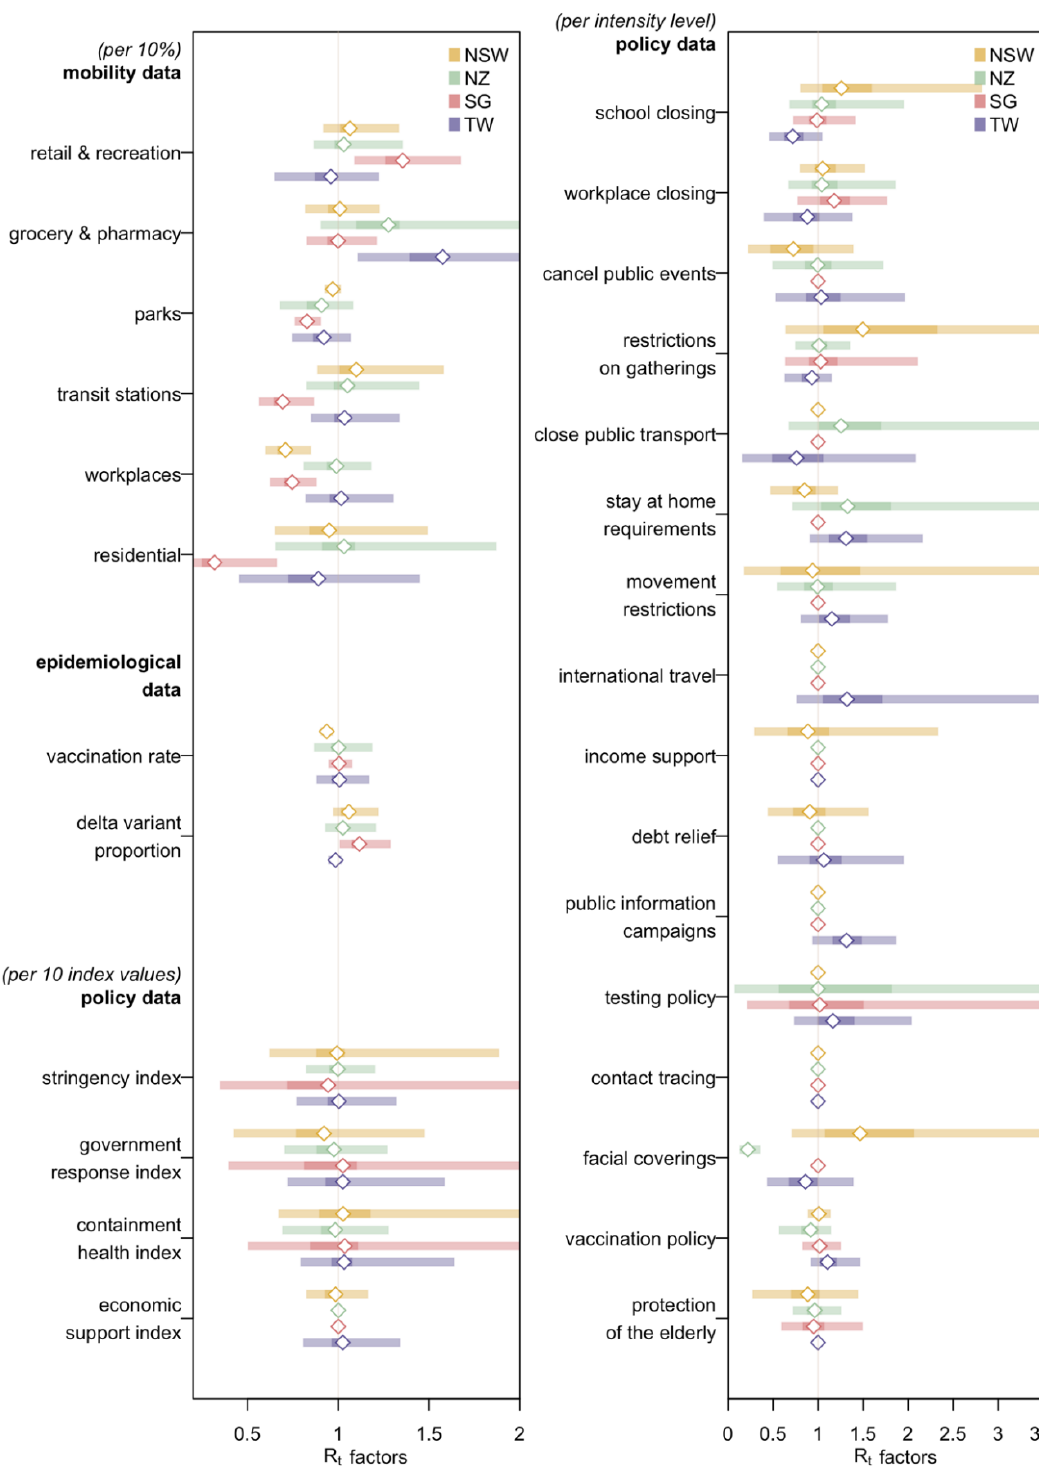
Figure 4. Impacts of different factors on R t (posterior medians, 50% and 95% credible intervals) for the four different regions in the full model with all the covariates available. Mobility factors were measured as percentage changes compared to a pre-COVID-19 outbreak baseline for each region; Vaccination rate refers to the proportion of the vaccinated population and policy indicators were ordinal variables indicating intensity levels, each ranging from zero (the least severe) to a maximum of five (the most severe). Factors related to different phases in Singapore were excluded from the model in this comparison of different factors’ effects on R t (Figure